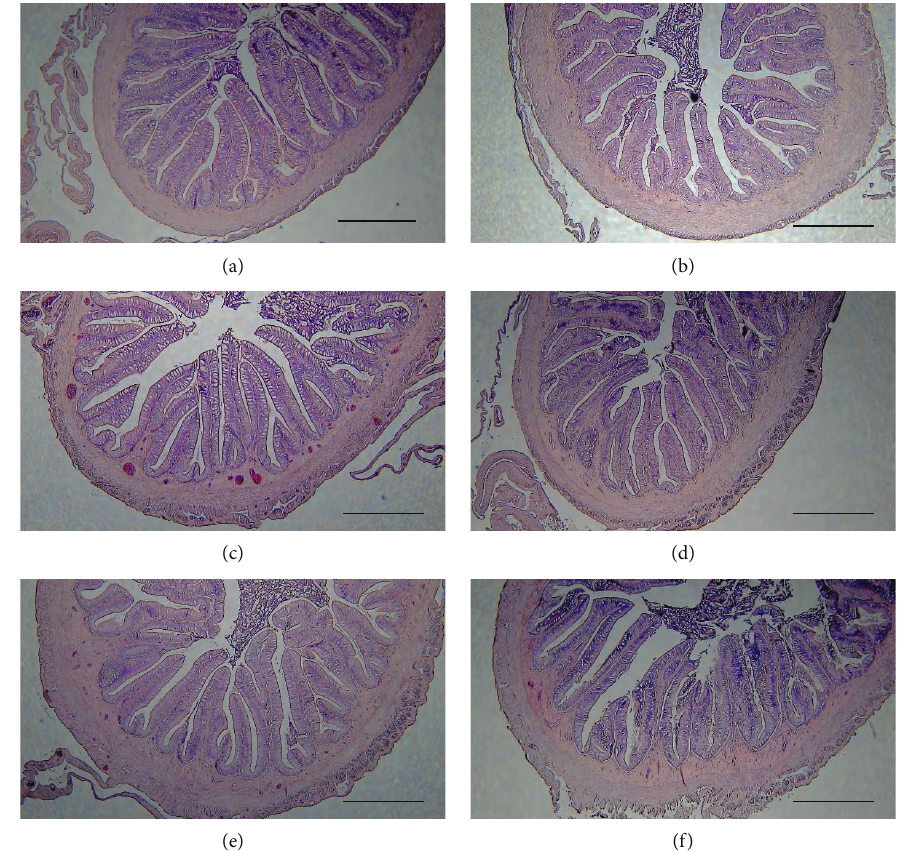
Figure 1: Histological sections of midgut of Japanese eel fed with di ff erent replacement levels of defatted black soldier fl y larvae meal (DBSFLM): R0 (a), R15 (b), R30 (c), R45 (d), R60 (e), and R75 (f). Midgut sections (6 μ m) were stained with hematoxylin and eosin. Bars in bottom right-hand corner represent 500 μ